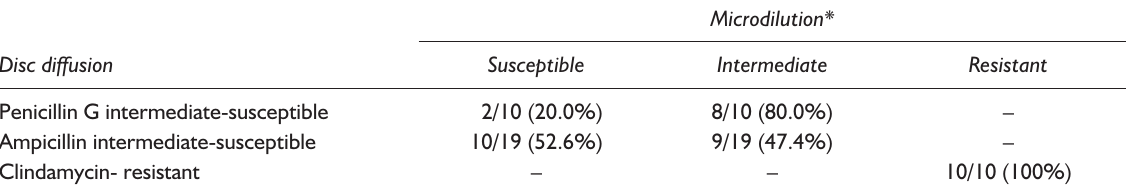
Table 2 Microdilution susceptibility analyzes of GBS isolates determined to intermediate or resistant by disc diffusion